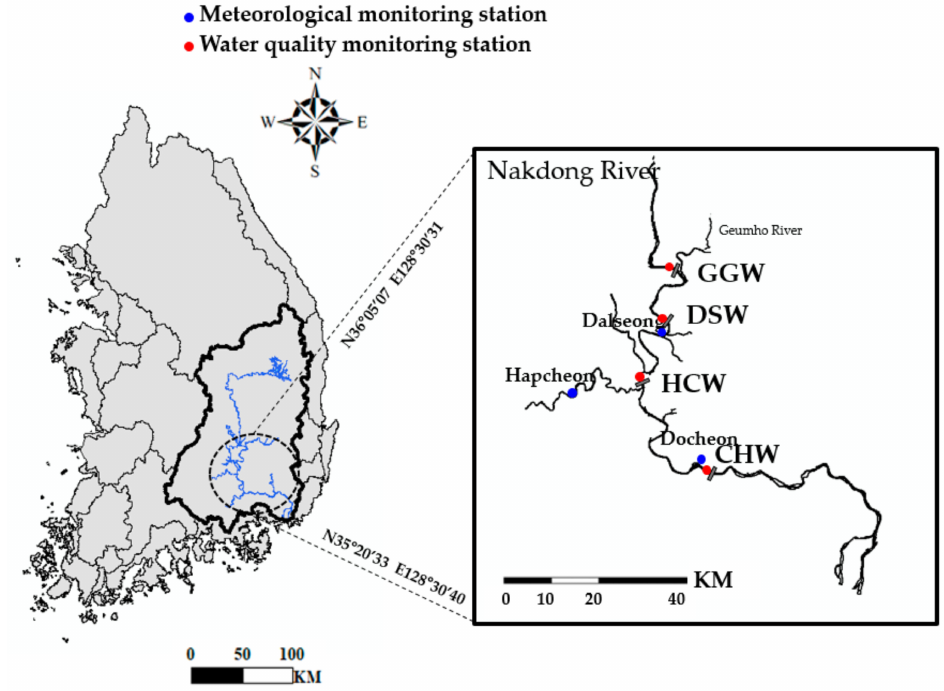
Figure 1. Locations of study weirs and sampling stations; Gangjeong Goryeong weir (GGW), Dalseong weir (DSW), Hapcheon Changnyeong weir (HCW), and Changnyeong Haman weir